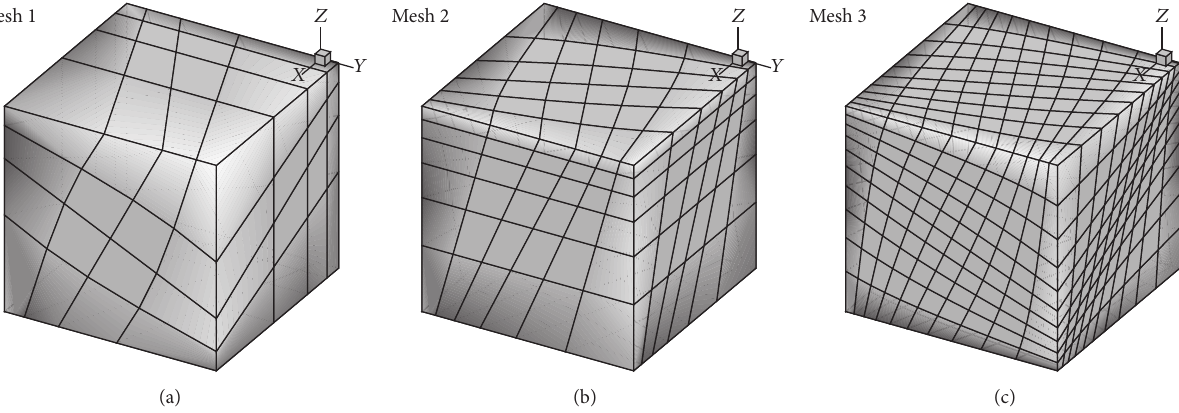
Figure 10: Cubic block under uniform tension and body force: (a) mesh 1 (4 × 4 × 4 elements), (b) mesh 2 (6 × 6 × 6 elements), and (c) mesh 3 (10 × 10 × 10